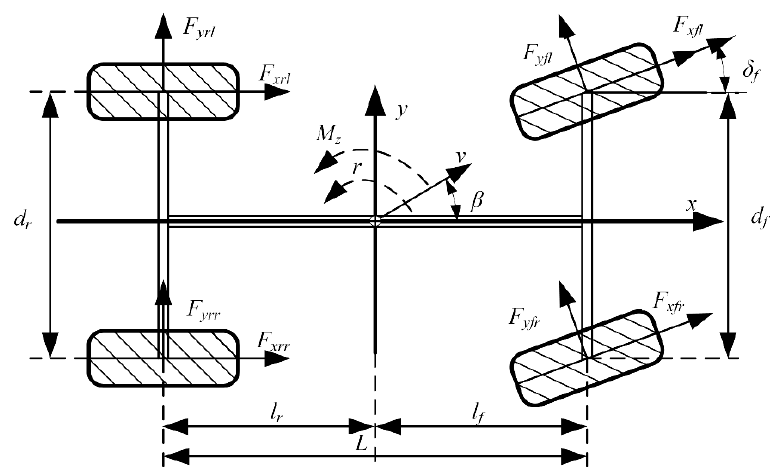
Table 1. Vehicle parameters.